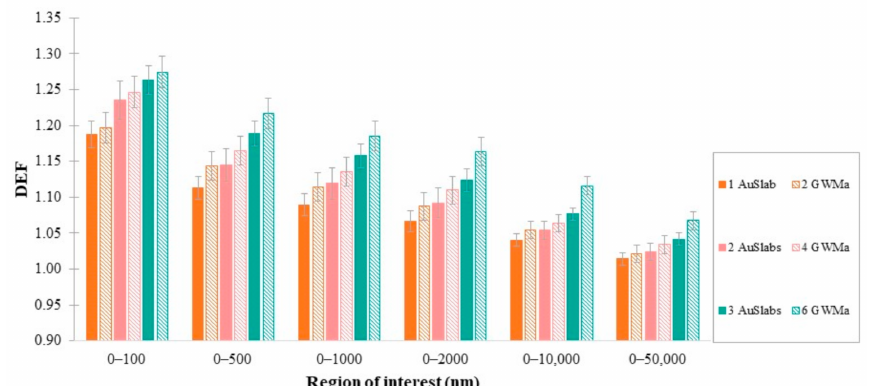
Figure 7. Comparison between different arrangements of the same mass of AuNPs. The size of all examined clusters was 100 nm, and the photon field used to irradiate AuNPs clusters was 5 × 5 cm 2 (FFF). AuNPs clusters were positioned at a depth of 2 cm inside the mathematical water phantom.